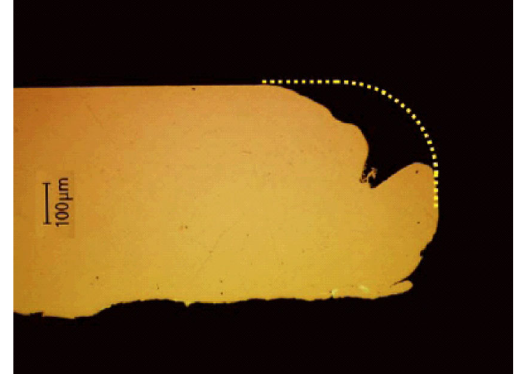
FIG. 5. (Color) Input coupler iris (the dotted line represents the iris geometry before rf processing); this figure is reproduced from Ref.